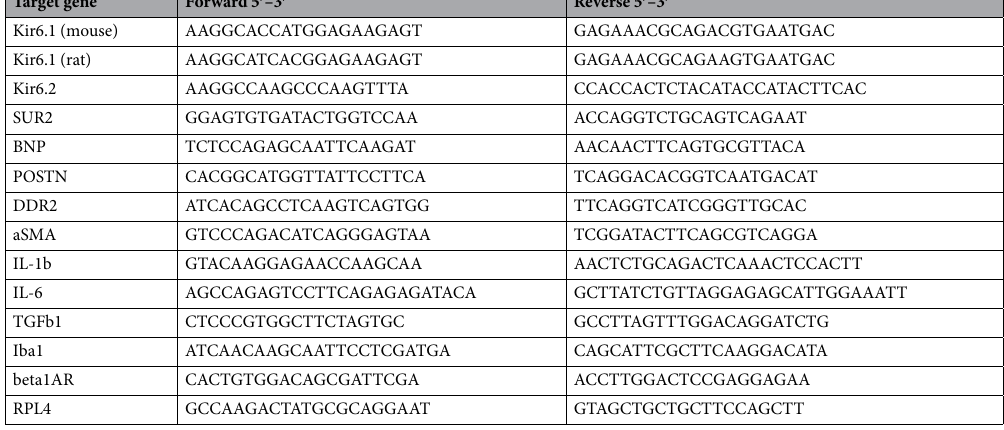
Table 2. Primer sets used for real-time PCR